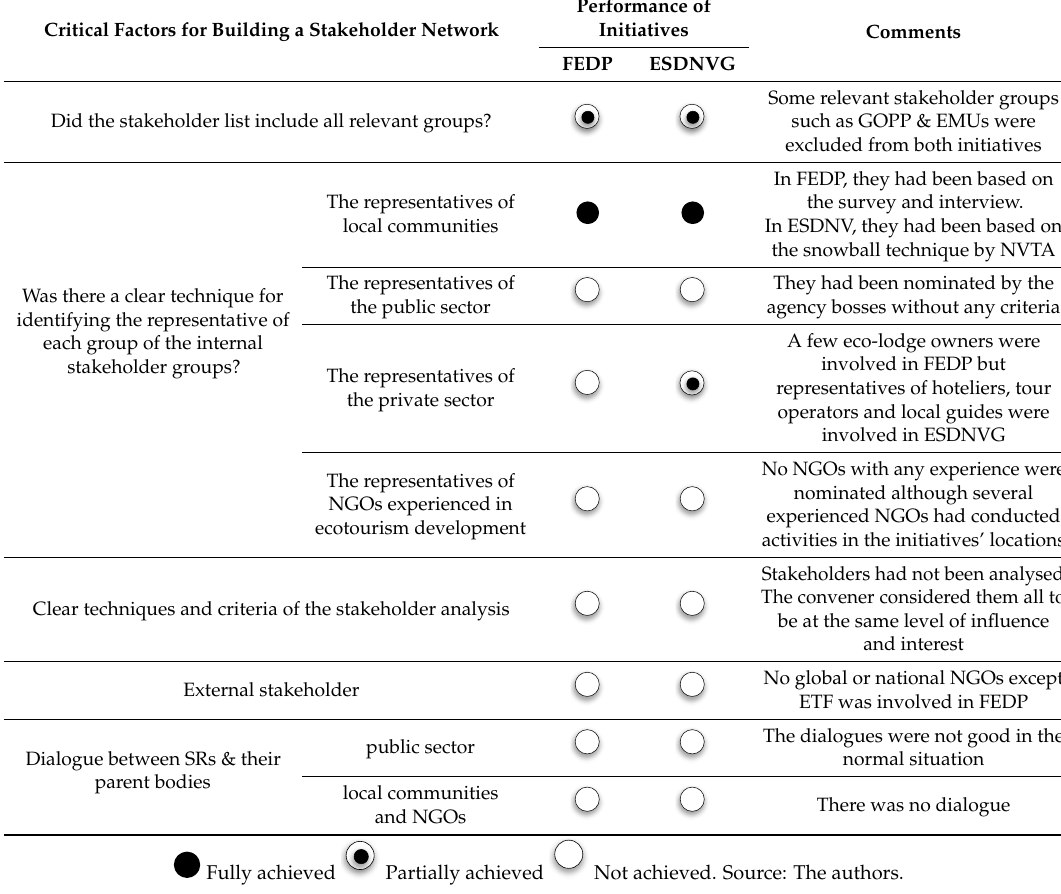
Table 1. Insufficient stakeholder network building during Egyptian ecotourism